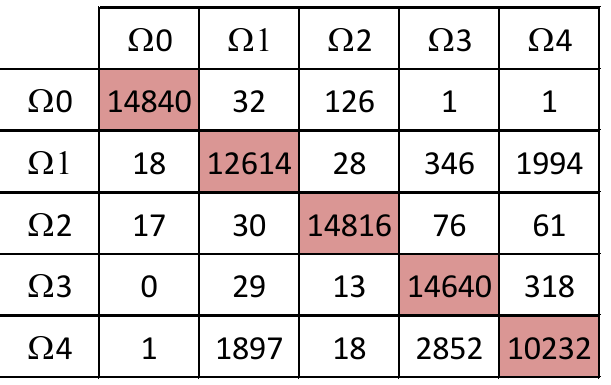
Figure 12. Two operators, Gaussian blurring with standard deviation 1.0 (GAU_1.0) and up-sampling with factor 1.5 (UP_1.5) are considered. The performance of the proposed CNN can degrade on compressed images in comparison to the uncompressed images.